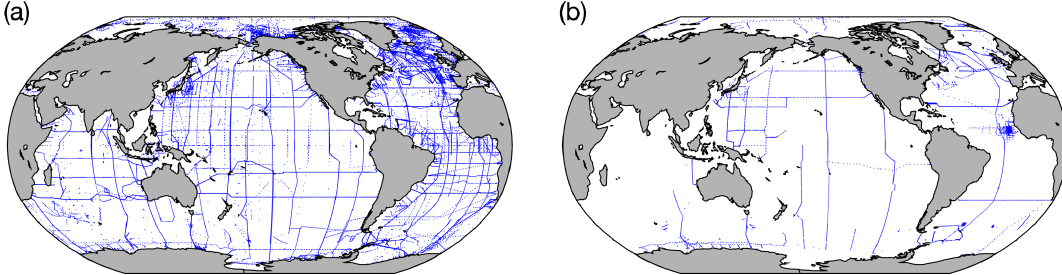
Figure 1. Location of stations in (a) GLODAPv2 released in 2016 and for (b) the new data added in this update. Table 2. WOCE flags in GLODAPv2.2019 exchange format original data files and product files.